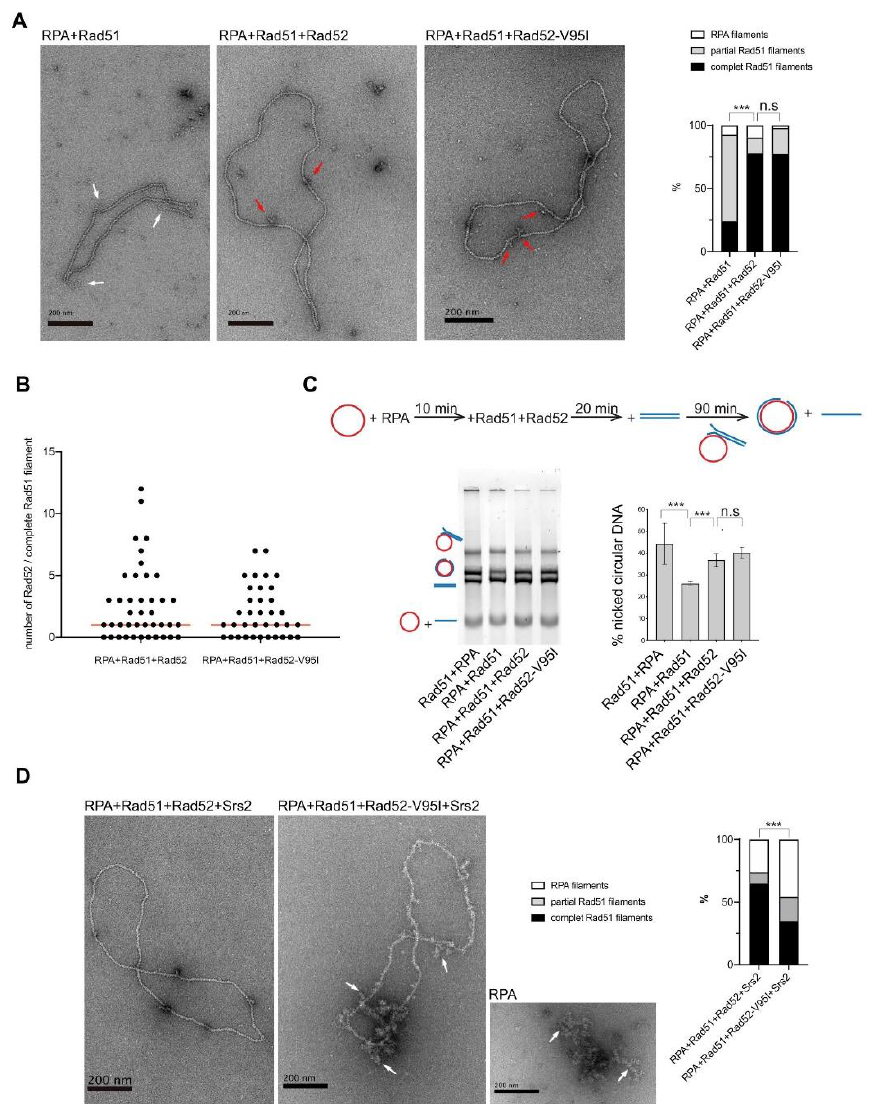
Figure 9. Rad51 filament formation by Rad52-V95I. All experiments were performed with FLAG-tagged Rad52 proteins. ( A ) EM analysis of Rad51 filament formation. A representative nucleofilament issued from each reaction is shown. Addition of RPA before Rad51 (RPA+Rad51) results in the formation of partial Rad51 filaments. White arrows indicate the presence of RPA on ssDNA. Concomitant addition of Rad52 with Rad51 in this reaction (RPA+Rad51+Rad52) leads to complete Rad51 filaments associated with Rad52 (red arrows). The percentage of each molecular species is plotted on the